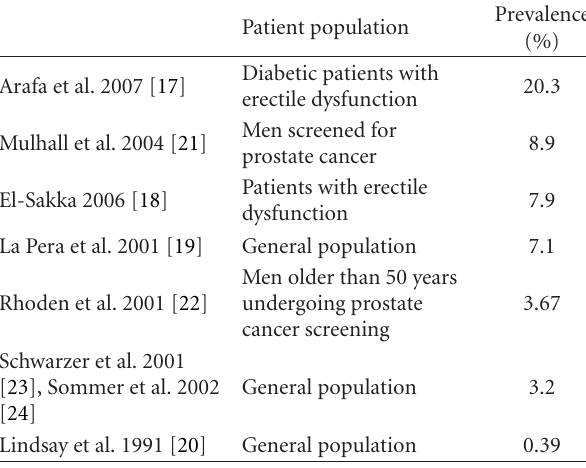
Table 1: Prevalence of Peyronie’s disease from the literature.